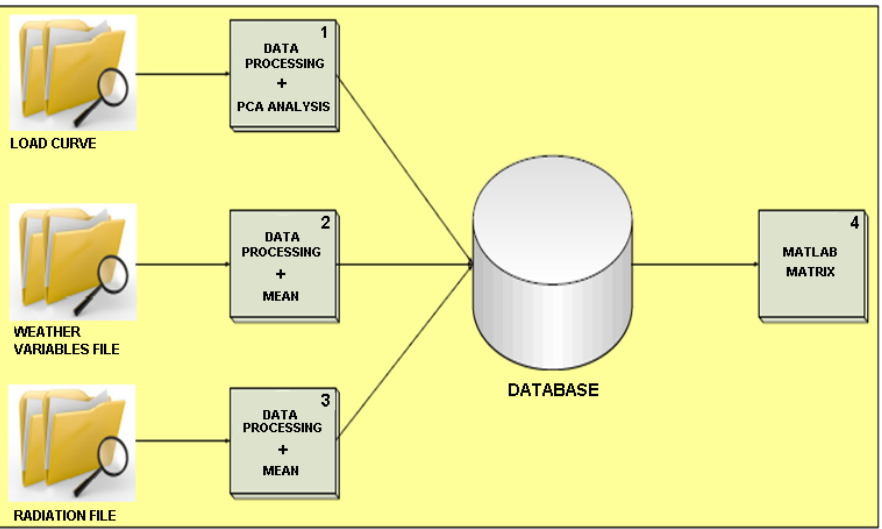
Figure 5. Information Processing